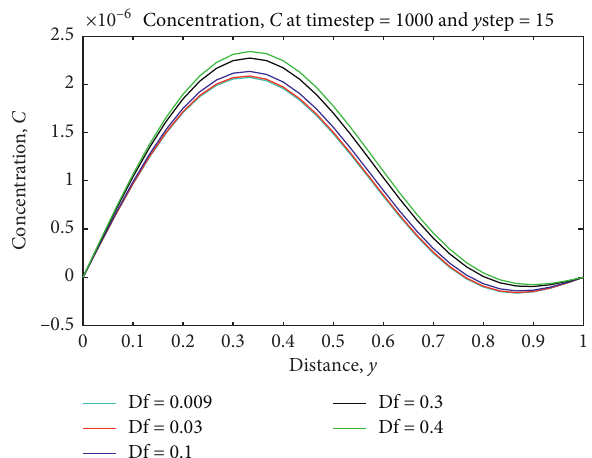
Figure 14: Effects of Dufour number on concentration